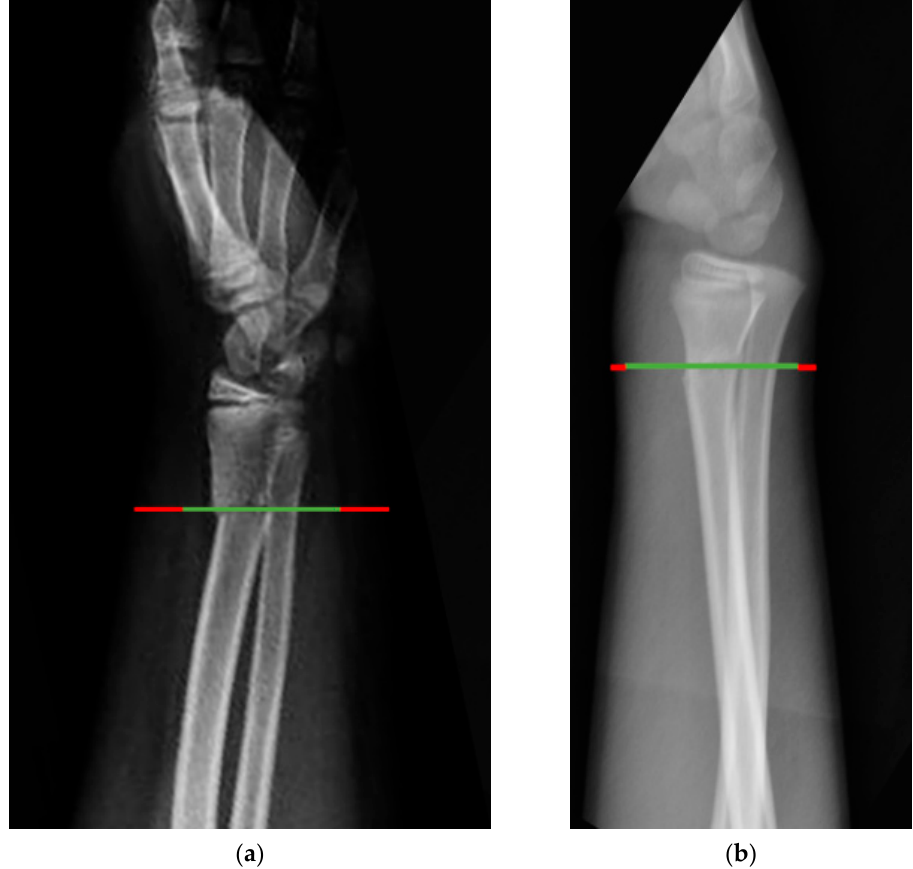
Figure 1. A comparison of the lateral view of the fat layer (red lines) at a fracture site (green lines) between ( a ) an obese patient and ( b ) a patient of normal weight matched for age and